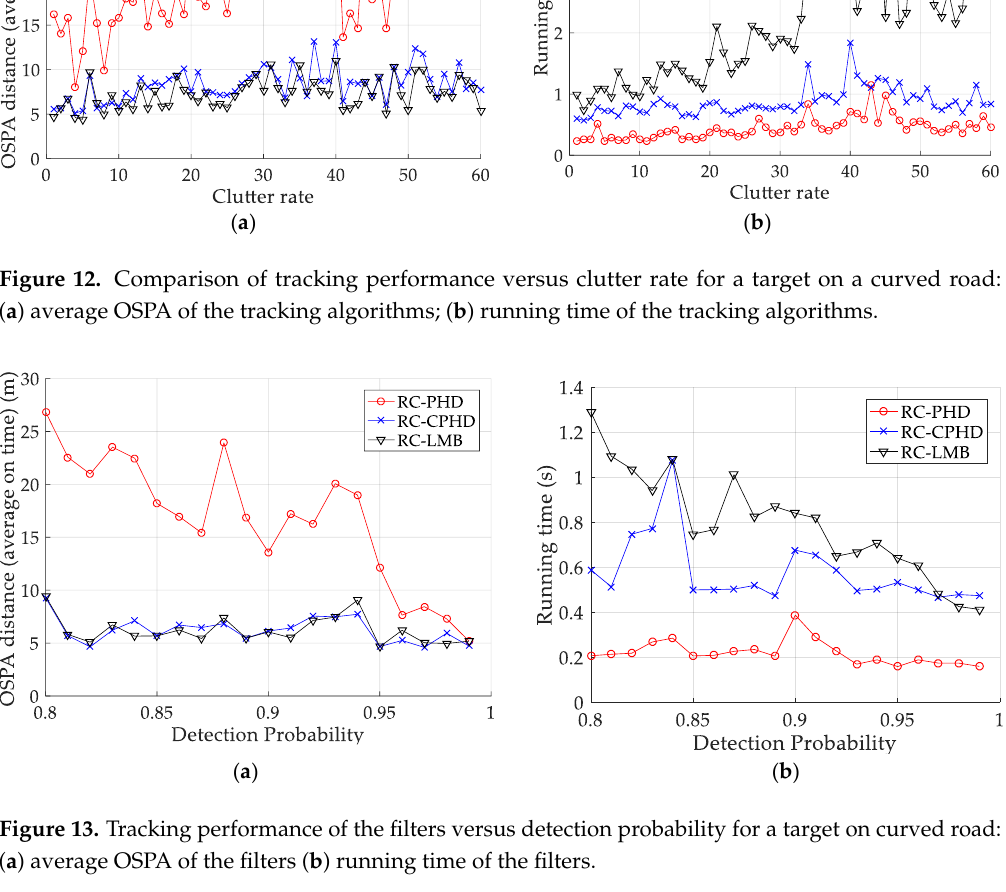
Table 8. Average OSPA distance and running time of different filters with different clutter rates when the detection probability is equal to 0.95.